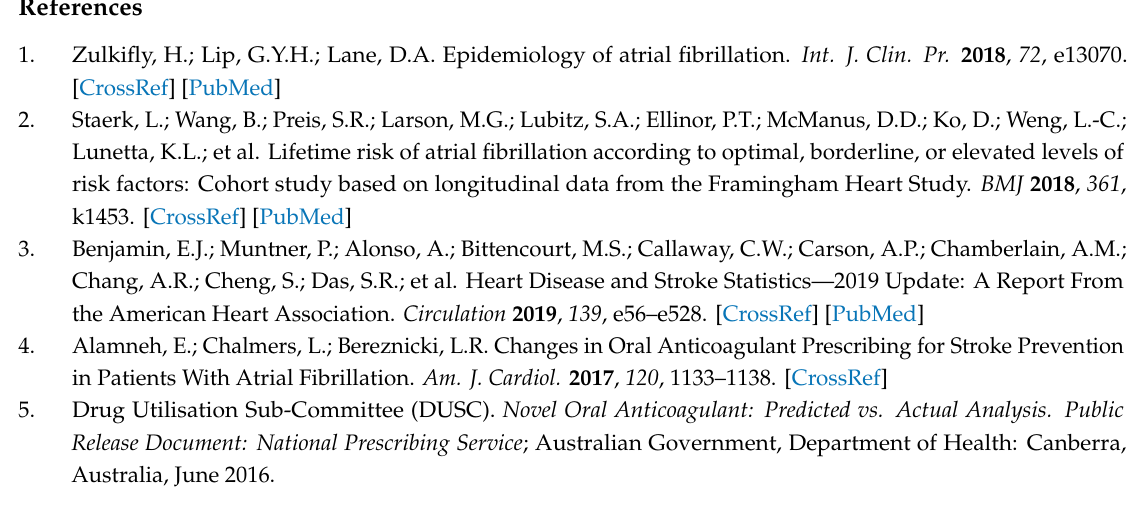
Table S1. Trends in potential drug interactions with DOACs in patients with atrial